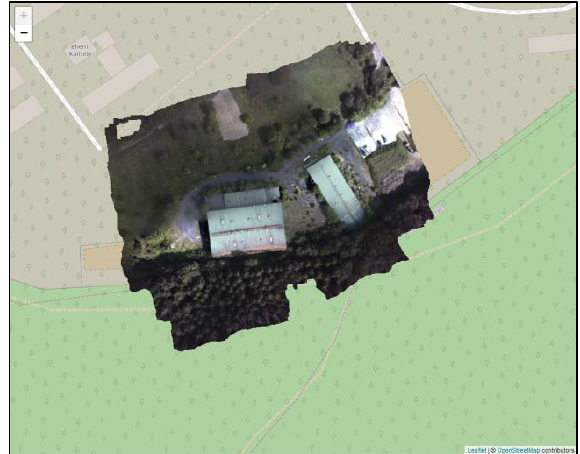
Figure 18: A leaflet based web map created for the orthophoto of the studied area. The orthophoto is published using Geoserver and defined as a layer with its own URL, which is used in leaflet based map.